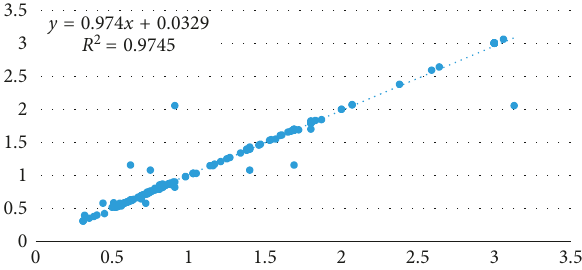
Figure 8: ANN training results for the prediction of the U-opaque in block buildings.